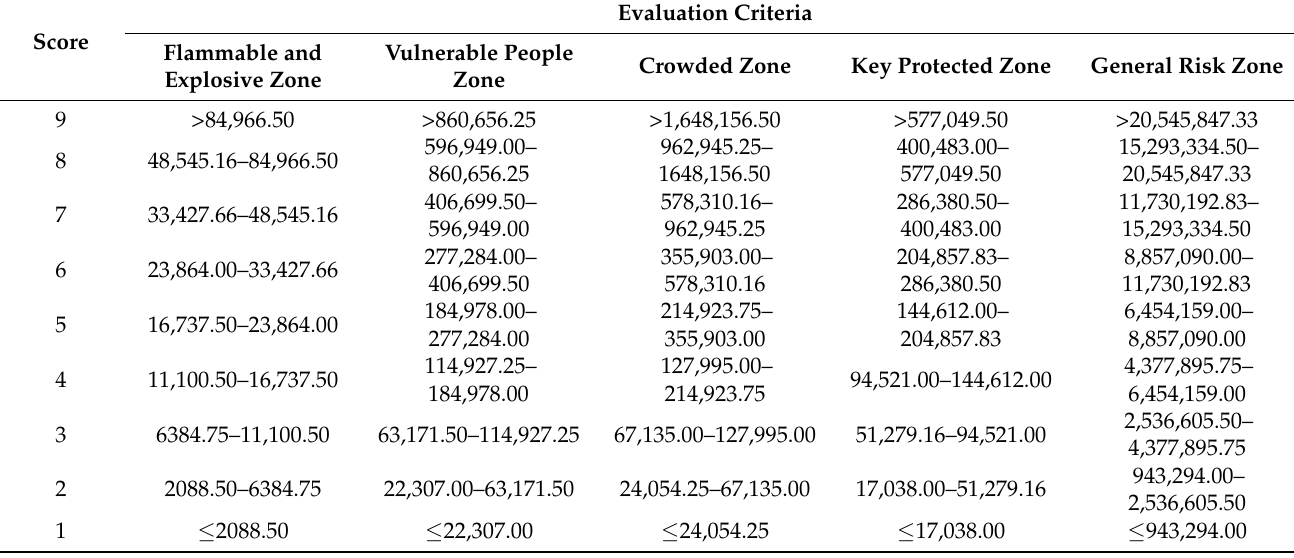
Table 7. Reclassification of the assessment criteria and corresponding scores.